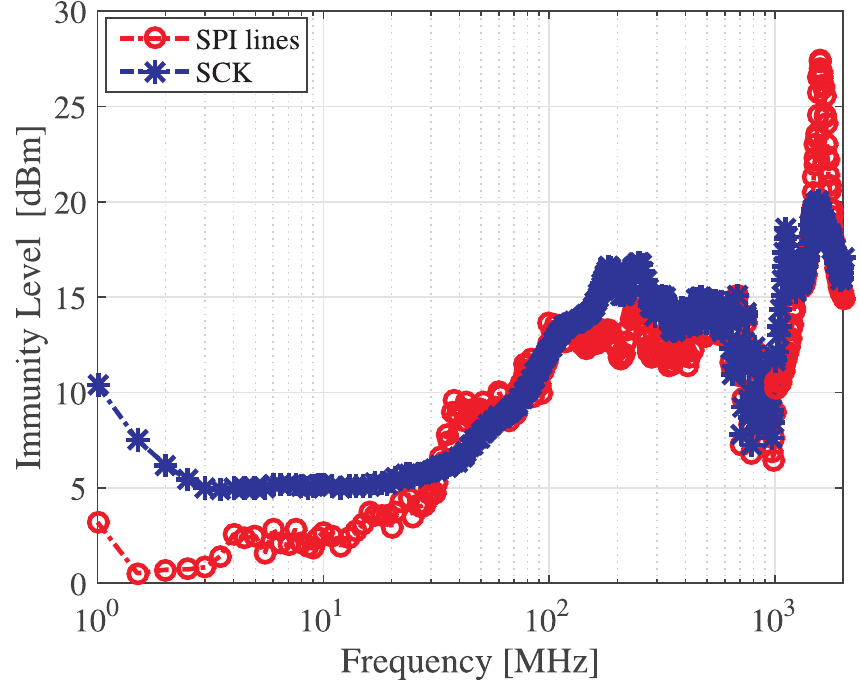
Figure 9. Measured immunity level for DPI on the SPI input pins: simultaneous injection on the four SPI lines and injection on the single SCLK line.